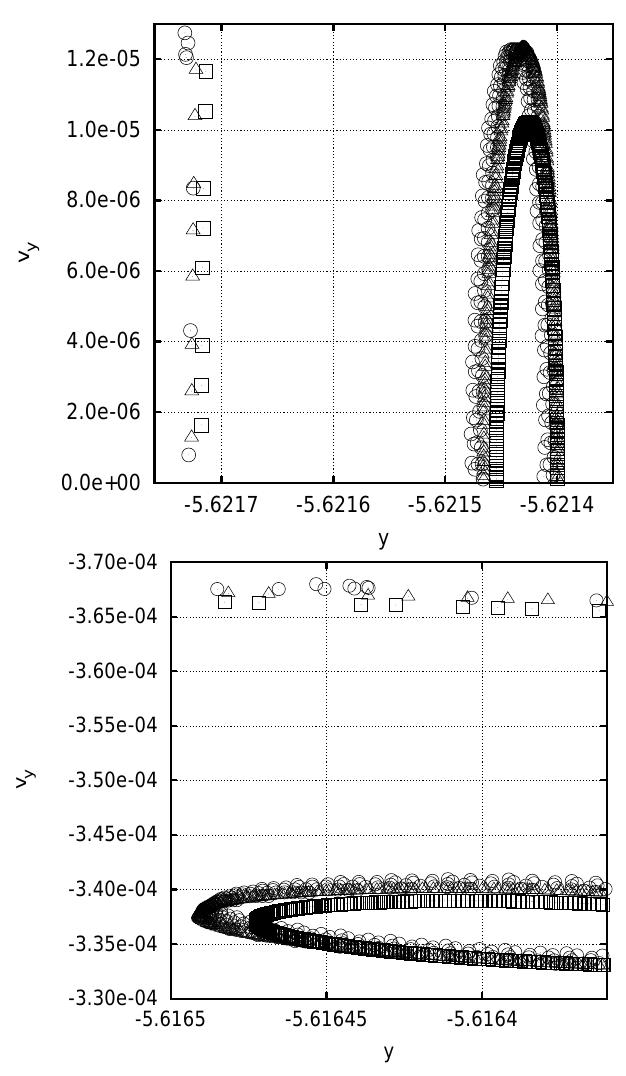
Fig. 16. Extreme closeups from Poincar´e maps produced by the SYMP method run 9 (dotted squares) and RK78 method run 9 (dotted circles) overlaid on the truth model (dotted